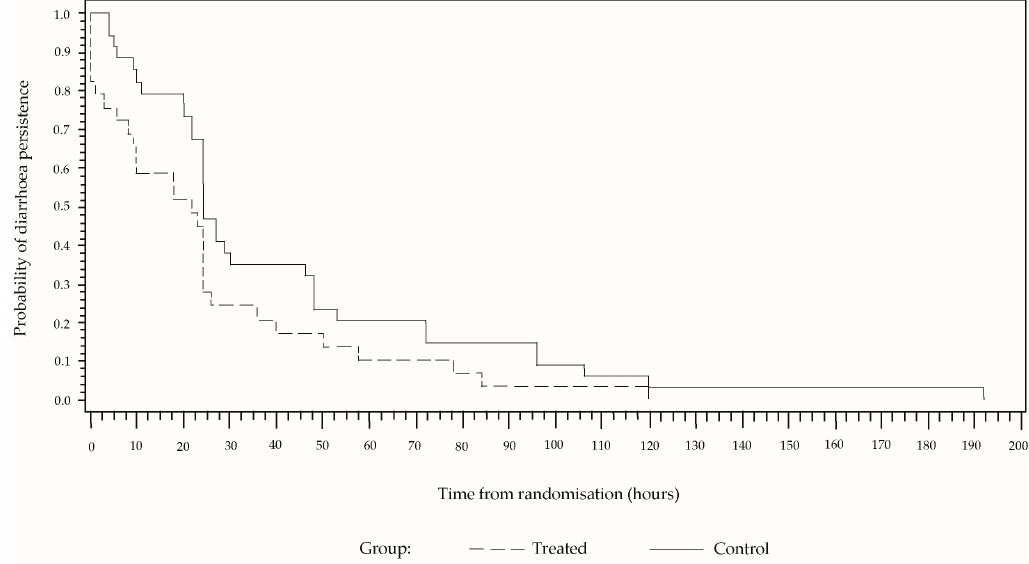
Figure 2. Kaplan-Meier estimator. Estimated cumulative percentage of children with persistent